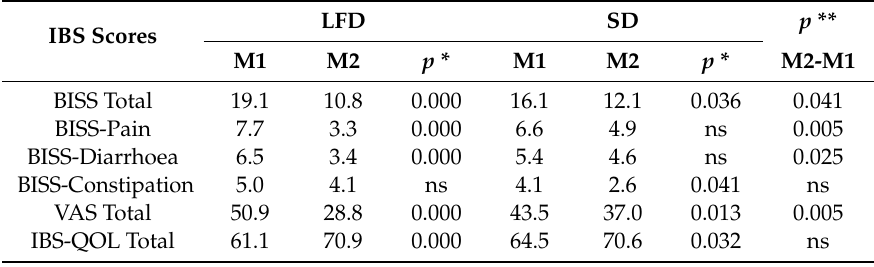
Table 2. Symptoms and Quality of Life